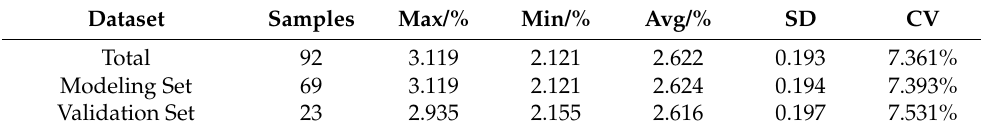
Table 2. Statistical indices of nitrogen